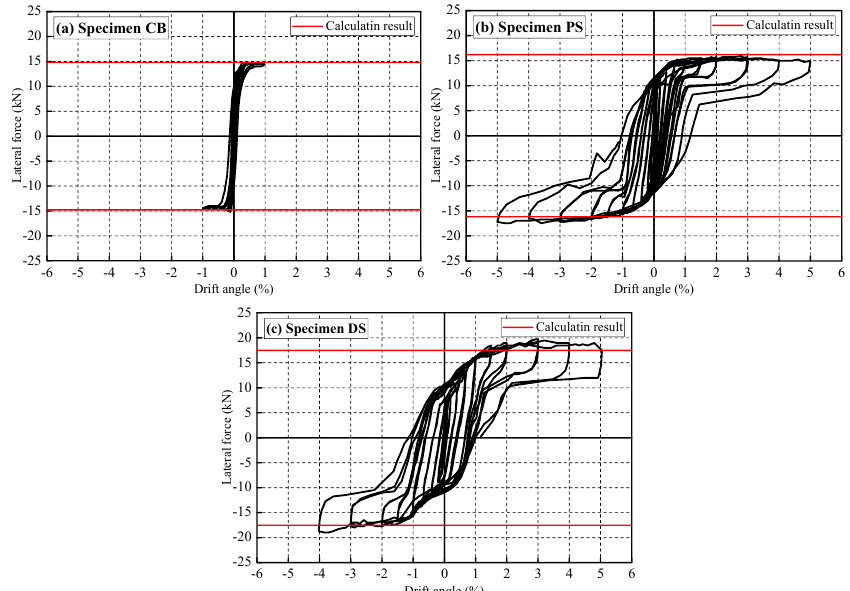
Figure 9. Lateral force-drift angle relationships of each specimen.